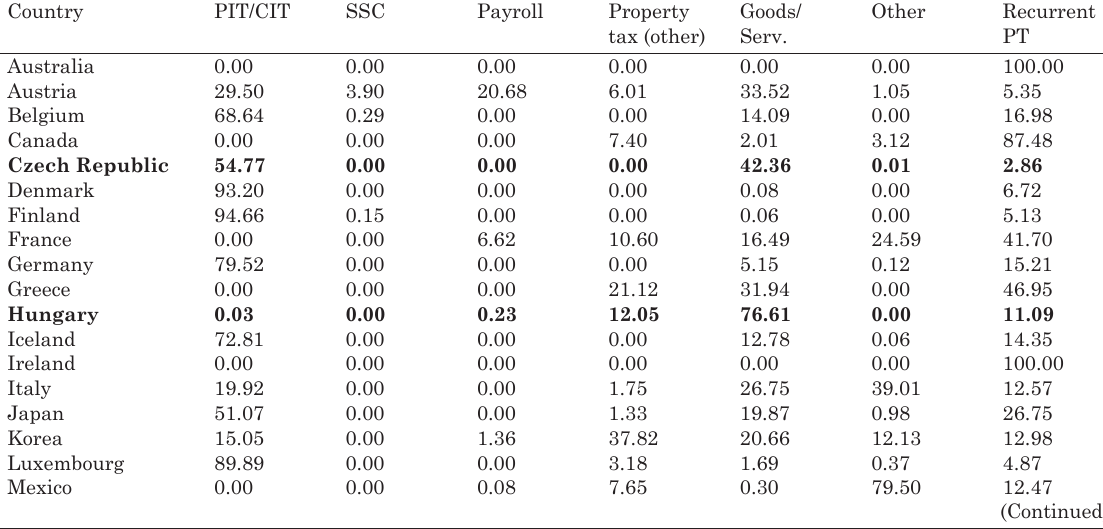
table 2. Tax revenue sources for local government